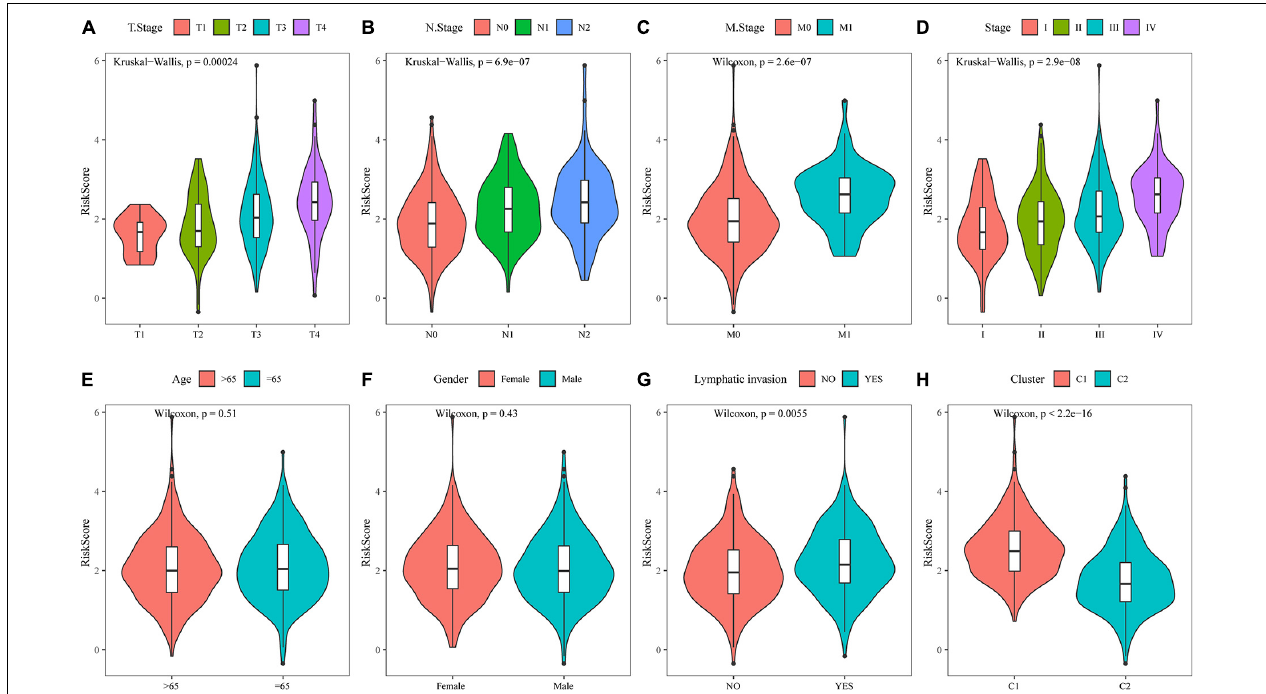
FIGURE 11 | Analysis of clinical characteristics of the risk model. (A) Comparison of the risk score between T stage subsamples. (B) Comparison of the risk score between N stage subsamples. (C) Comparison of the risk score between M stage subsamples. (D) Comparison of the risk score between stage subsamples. (E) Comparison of the risk score between age subsamples. (F) Comparison of the risk score between sex subsamples. (G) Comparison of the risk score between lymphatic invasion subsamples. (H) Comparison of the risk score between samples grouped by molecular subtype.